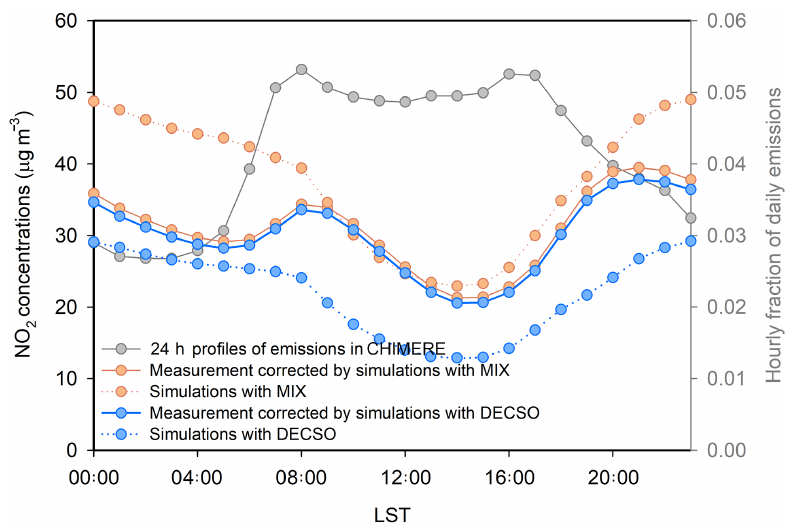
Figure 10. Diurnal variability in hourly average NO 2 concentrations. Values shown are annual averages for the year 2015. On the left axis the solid line represents the corrected in situ measurement. The dotted line represents the simulation driven by the DECSO inventory, 2015 (blue), and the MIX Asian inventory, 2010 (red). On the right axis the grey line represents the 24h profiles applied over the daily emissions to obtain hourly data in the CHIMERE